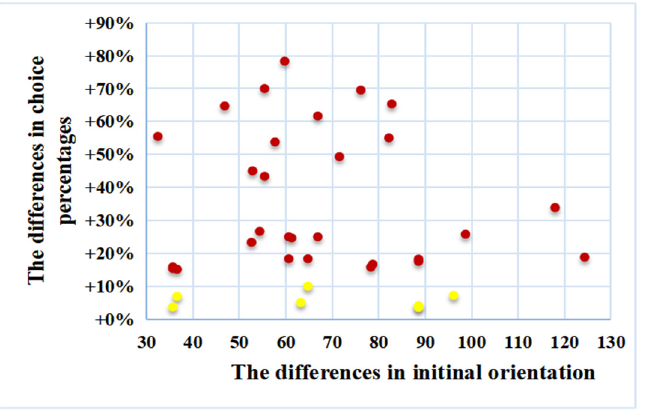
Figure 7. Differences in the choice percentages of the recommended routes with different initial orientations.